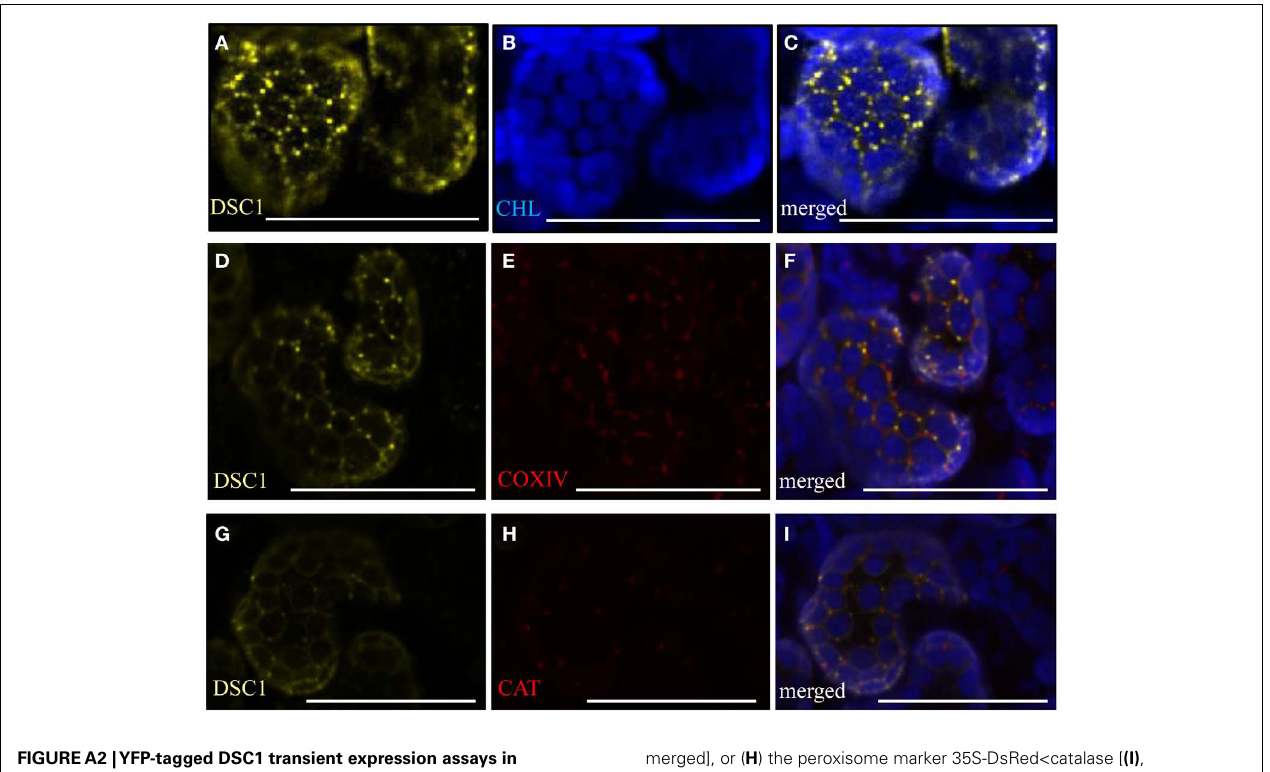
FIGUREA2 |YFP-tagged DSC1 transient expression assays in N. benthamiana . ( A,D,G ) 35S-YFP<DSC1 bodies do not co-localize with ( B ) chlorophyll auto-fluorescence [ (C) , merged], ( E ) the mitochondria marker 35S35SAMV-COXIV<GFP [ (F) ,